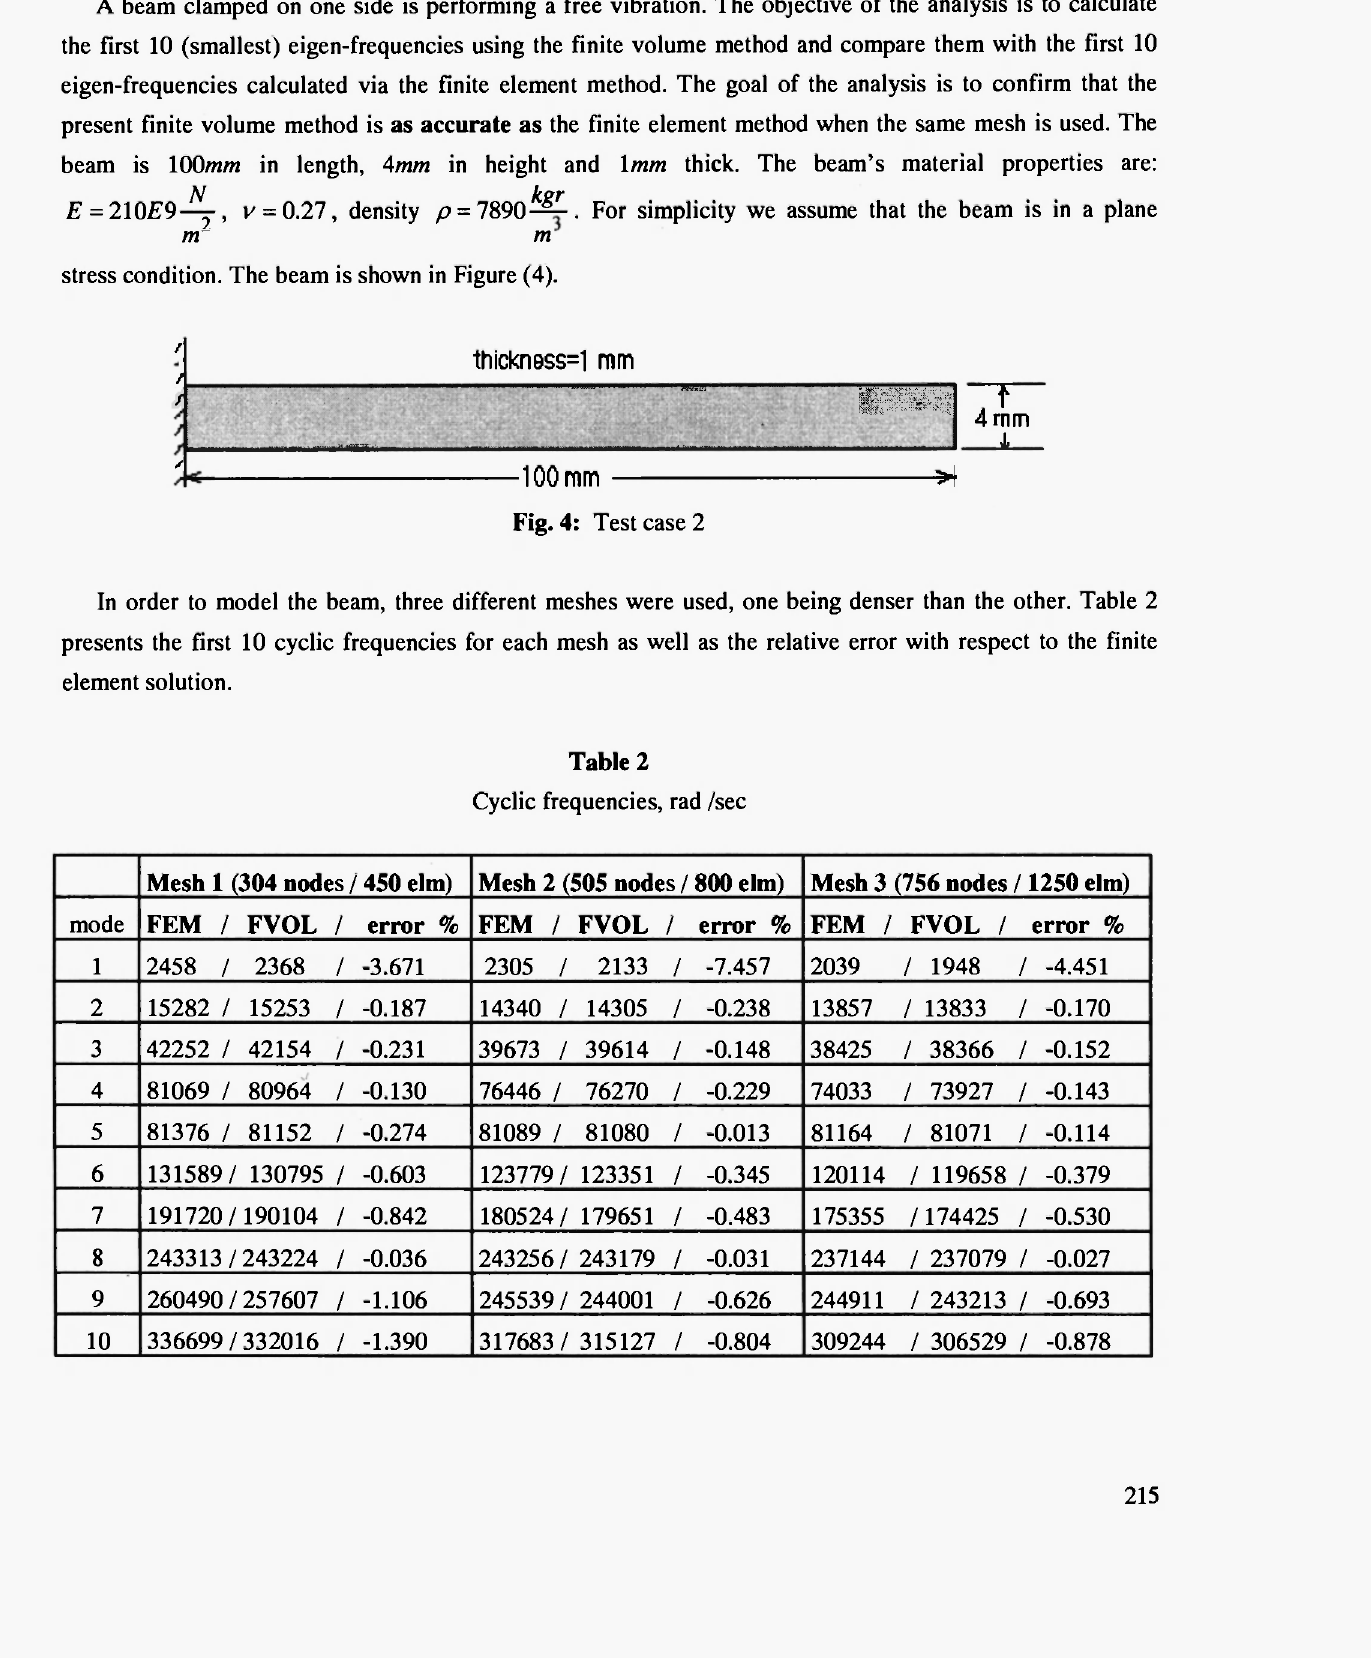
Cyclic frequencies, rad